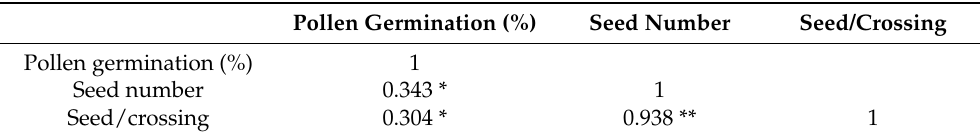
Table 2. Correlations between in vitro germination of preserved pollen in Rosa hybrida commercial cultivars and the fertility parameters (number of seeds and the ratio seeds/crossing), in modern rose commercial